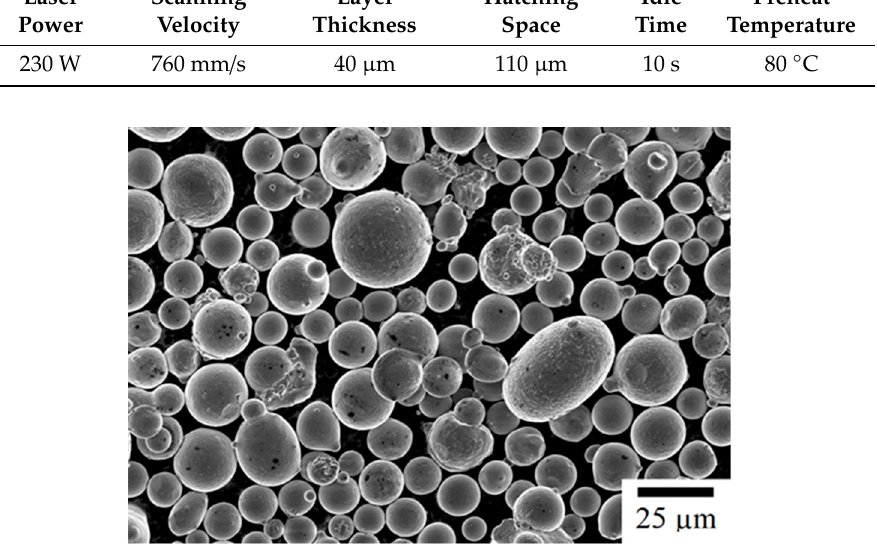
Figure 1. The morphology of Inconel 718 (IN718) powder.